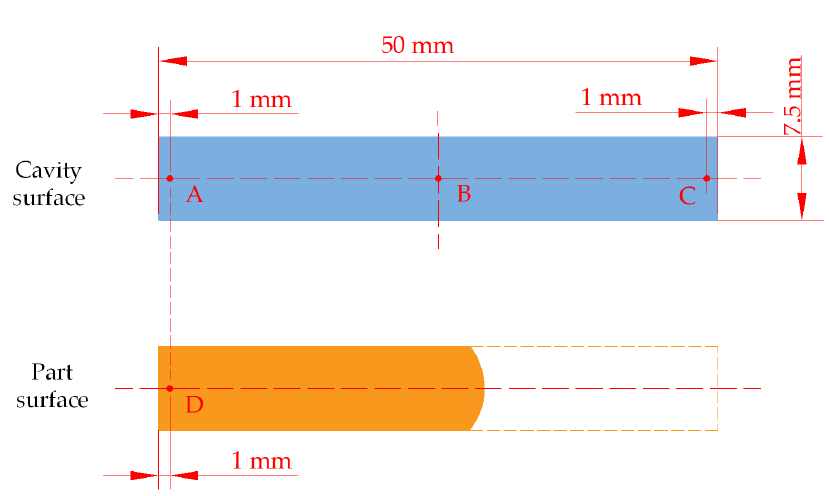
Figure 3. Measuring point of cavities surface roughness.